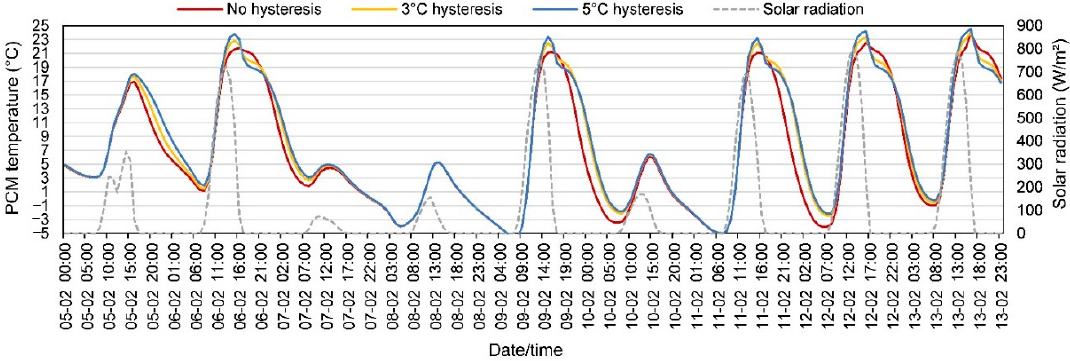
Figure 10. The PCM temperature profiles for models using PCM with different hysteresis degrees for winter energy storage application.